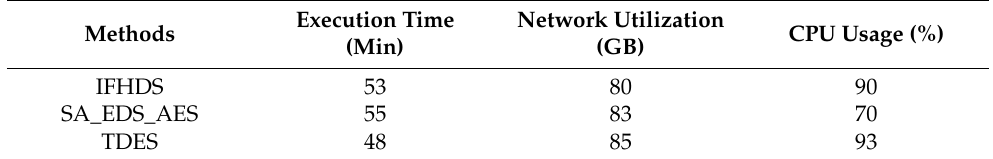
Table 3. Comparison table of proposed TDES methodology with existing methods.